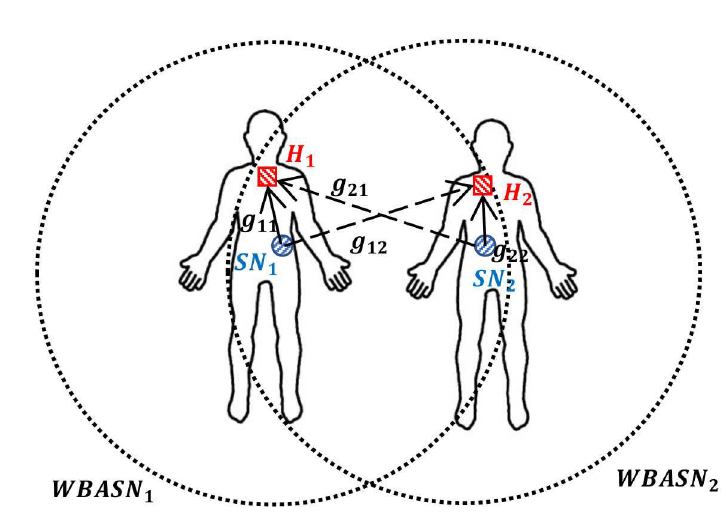
Figure 4. Inter-WBASN interference